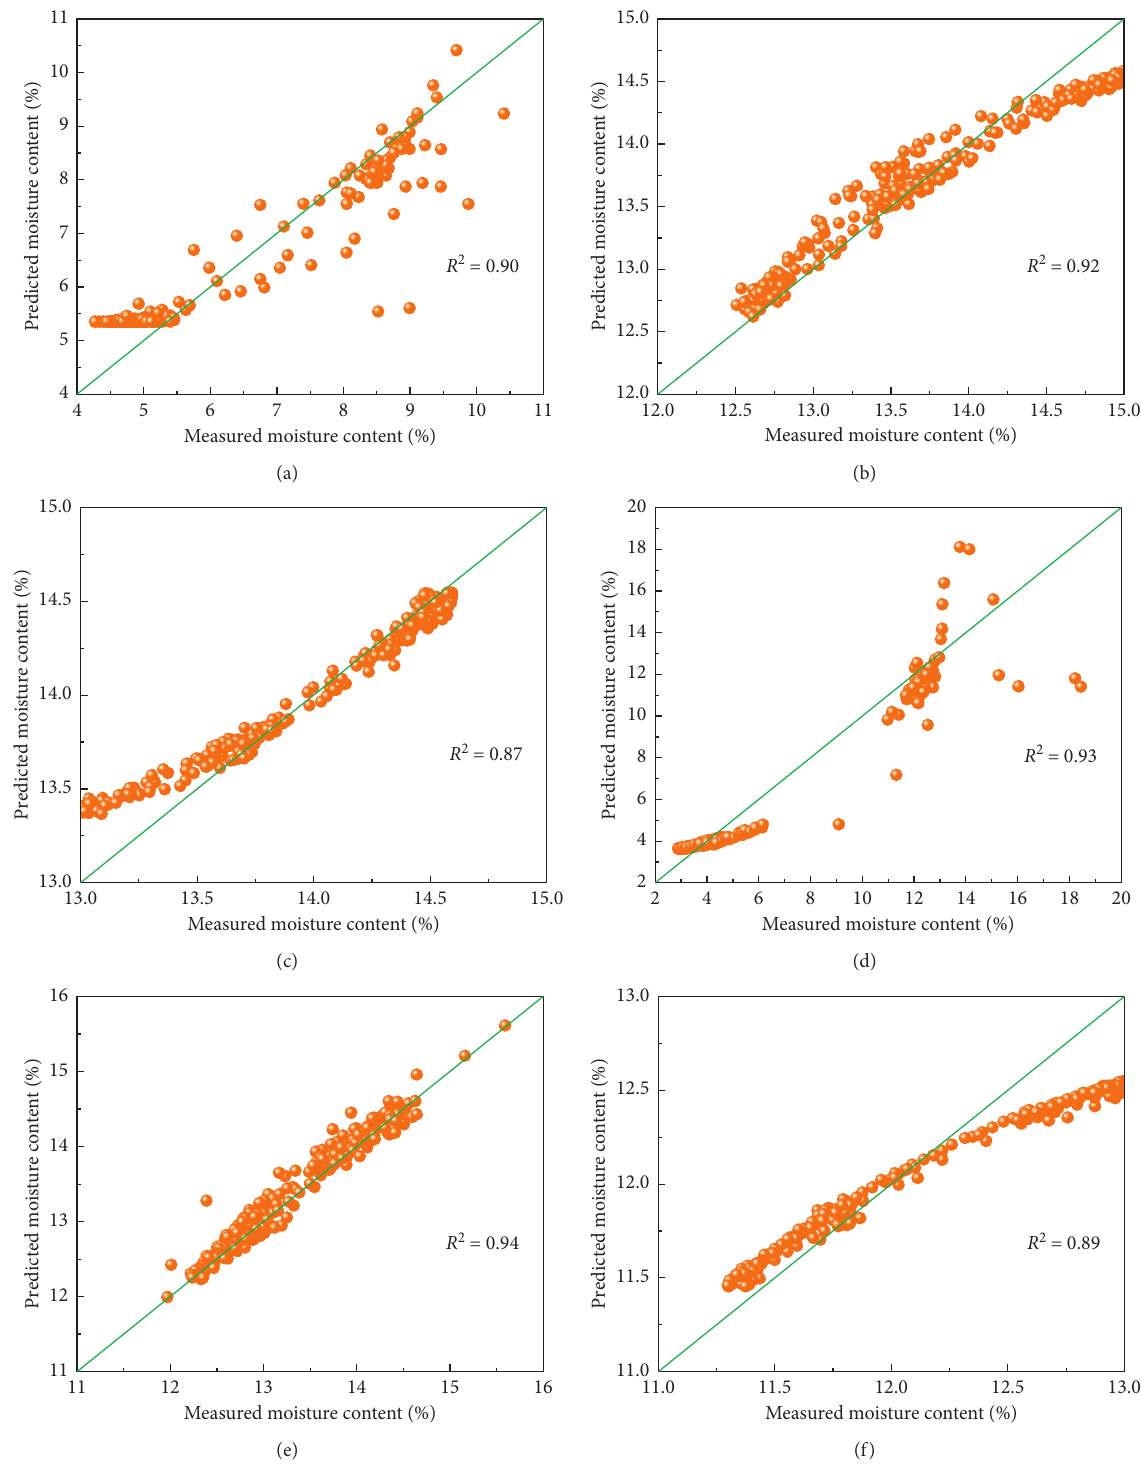
Figure 6: Comparison of the predicted values of the soil moisture with measured values (a–c) K 2020+024 section. (d–f) K 2028+746